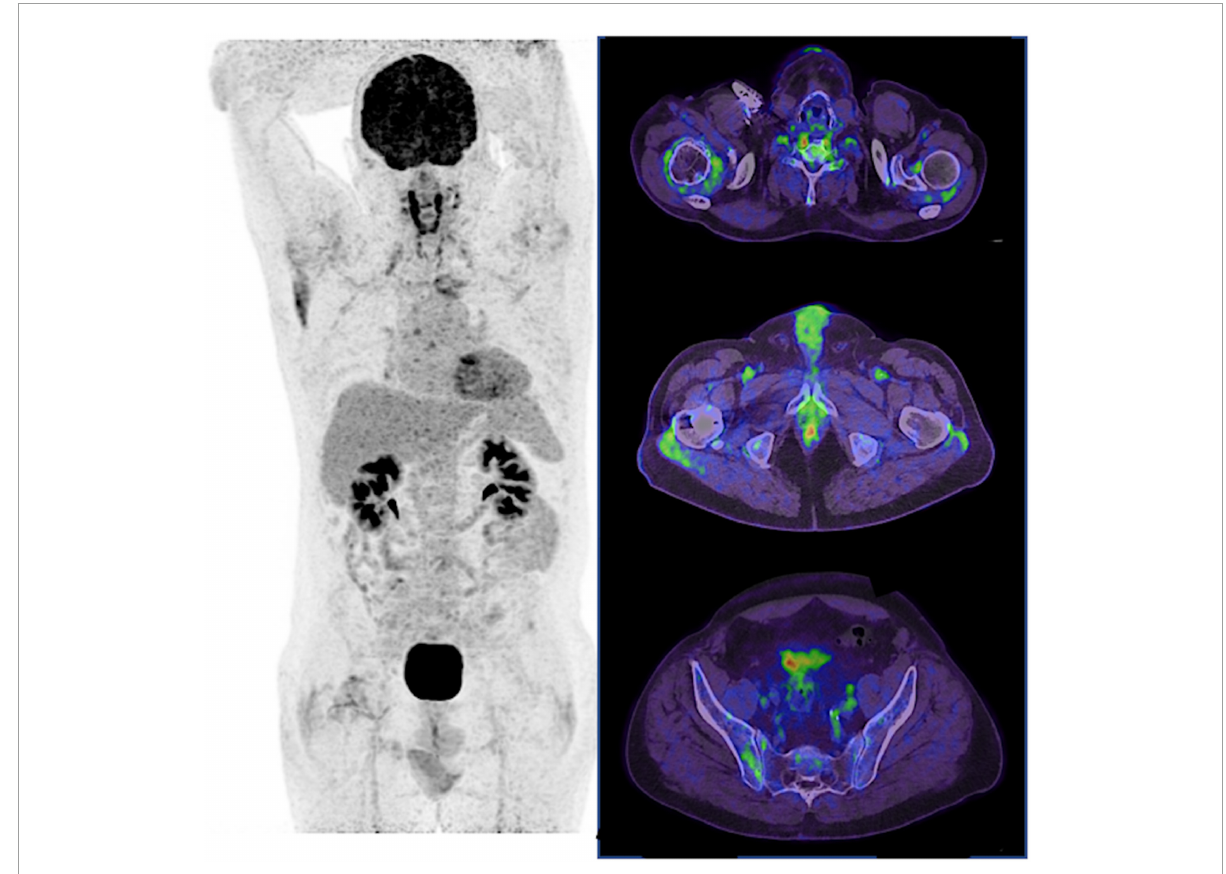
FIGURE2 18 F-FDG PET of SpA. In SpA, sacro-iliitis is a highly specific pattern of 18 F-FDG uptake, as illustrated here in the right sacro-iliac joint, but is rarely observed in practice. As for PMR, 18 F-FDG uptake of the sterno-clavicular joints, scapular and pelvic girdles is also